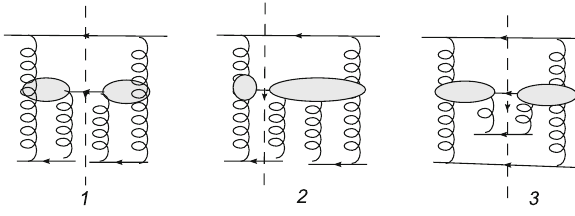
Fig. 4 Cut amplitudes with vertices (cid:2) R → RRG and (cid:2) R → RRRG